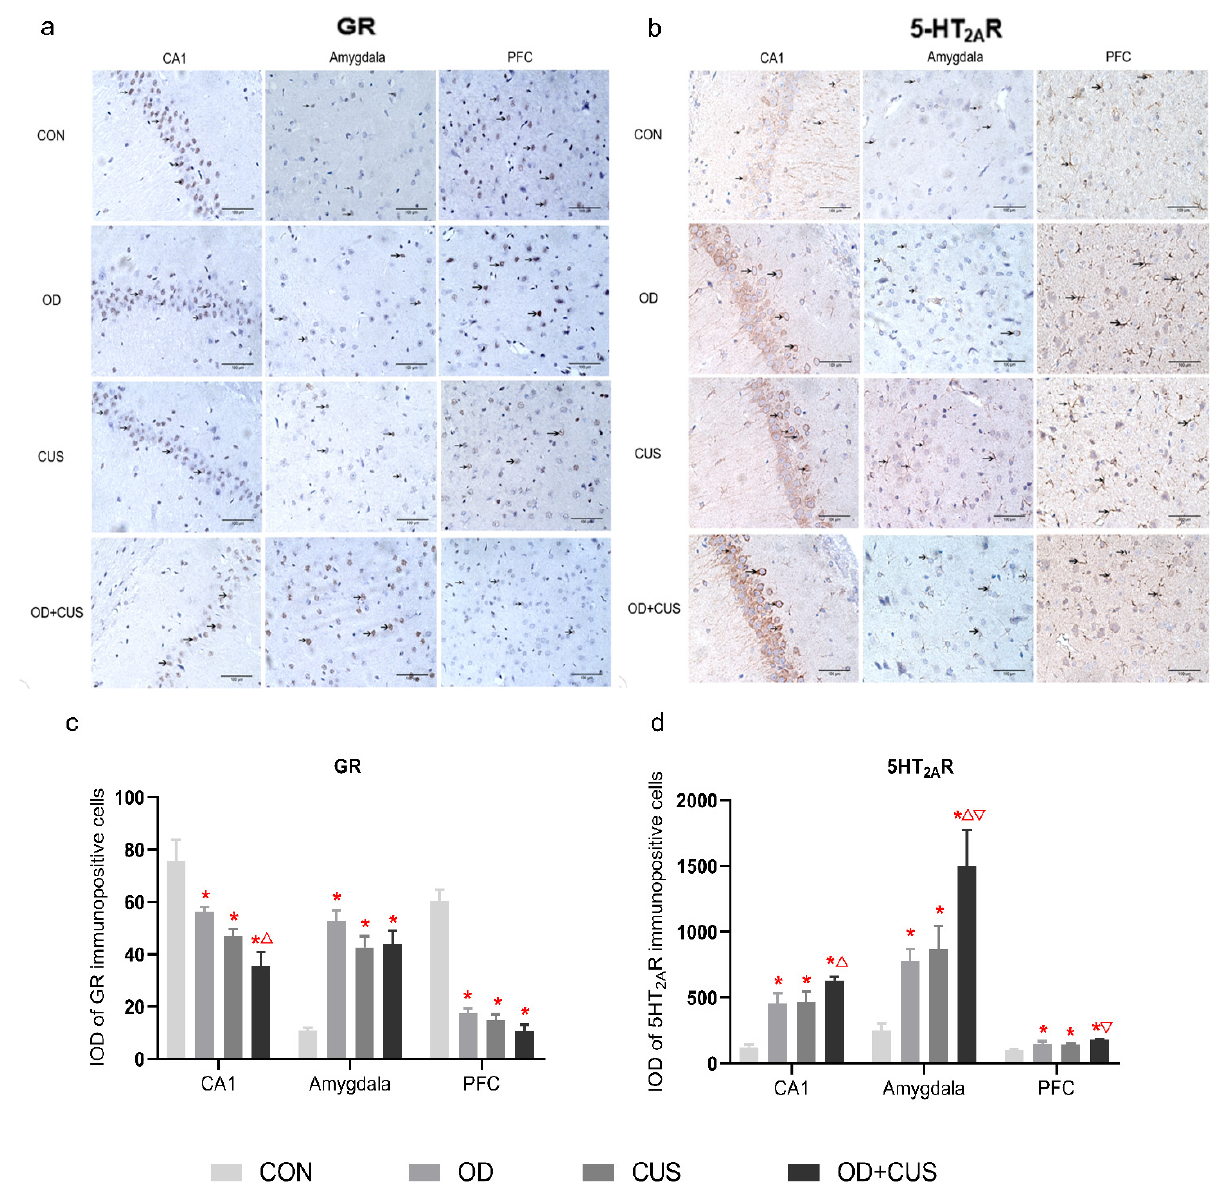
Figure 4. Analysis of GR and 5-HT 2A R expression in the hippocampal CA1, amygdala and PFC on day 56. ( a ) Representative photographs of immunohistochemical staining from the OD + CUS, CUS, OD and CON groups are shown. ( b ) Representative photographs of immunohistochemical staining for each group are shown. ( c ) The integral optical density (IOD) of GR immune-positive cells. ( d ) The integral optical density (IOD) of immune-positive cells. Data are shown as the mean ± SEM. * p < 0.05, compared with the CON group; (cid:53) p < 0.05, compared with the OD group; (cid:52) p < 0.05, compared with the CUS